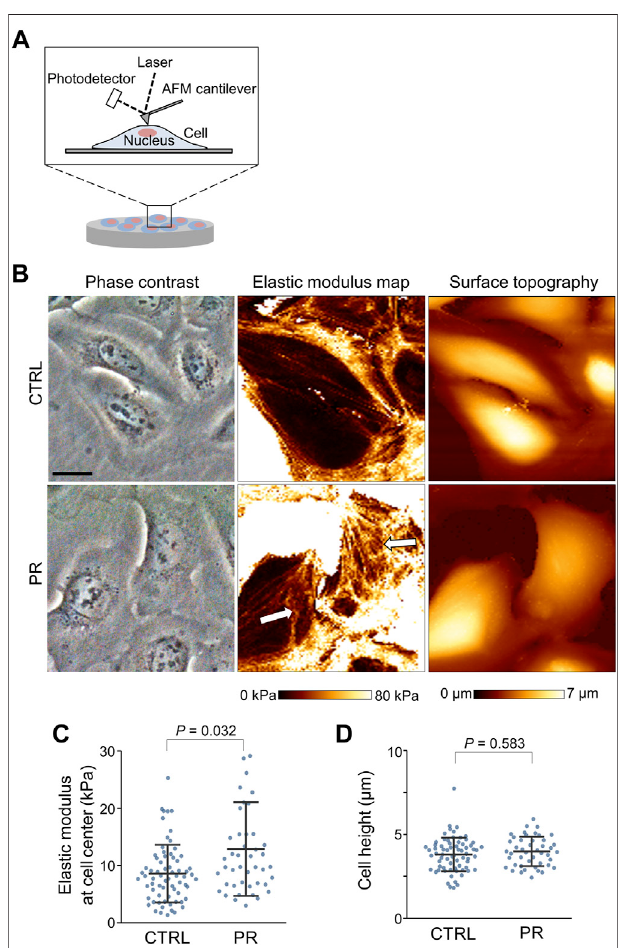
FIGURE 2 | Atomic force microscopy (AFM) images of the surface of U2OScells. (A) SchematicviewofAFMmeasurementofcellsurface,including cell stiffness and cell height. (B) Representative images of phase contrast images (left), elastic modulus maps (middle), and surface topographic images (right) of U2OS cells measured by AFM. Arrows in the middle image show thick- and short-stress fi bers in PR 20 -treated (PR) cells. Scale bars are 20 µm. (C,D) Quanti fi cationgraphshowselasticmodulusatcellcentralregion (in C) and cell height (in D) in CTRL and PR cells. Bars are means ± SD. 45 to 69. Cells were evaluated per condition. P value shows Mann – Whitney U